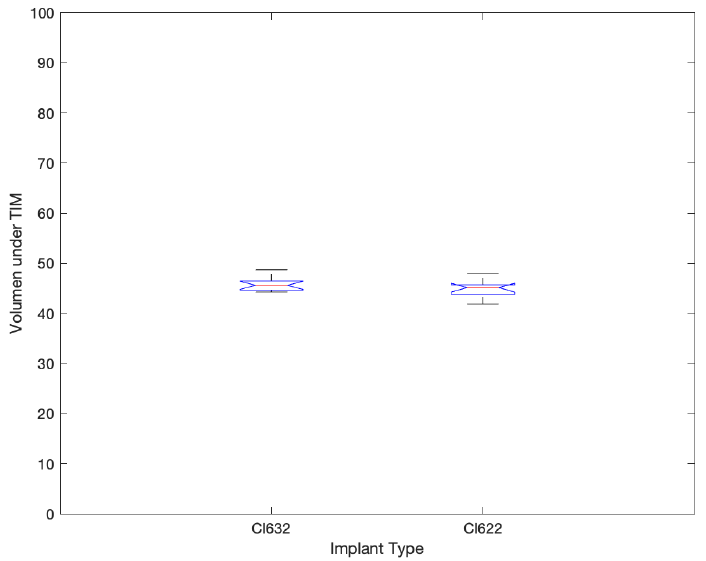
Figure 4. Volume under TIM result comparison chart between CI632 and CI622 recipients.